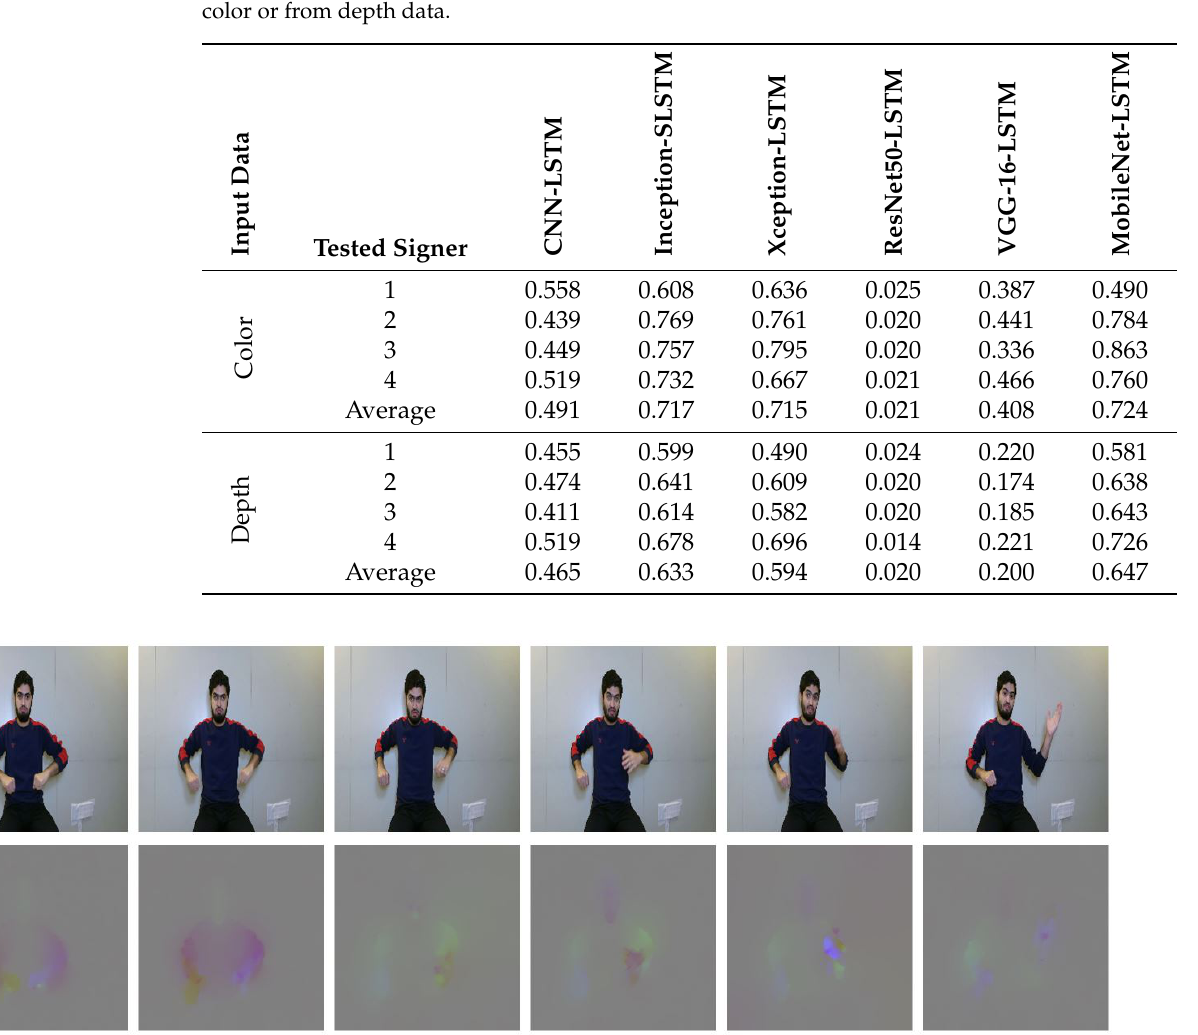
Figure 6. Selected frames of “VERY FAT” sign with their optical